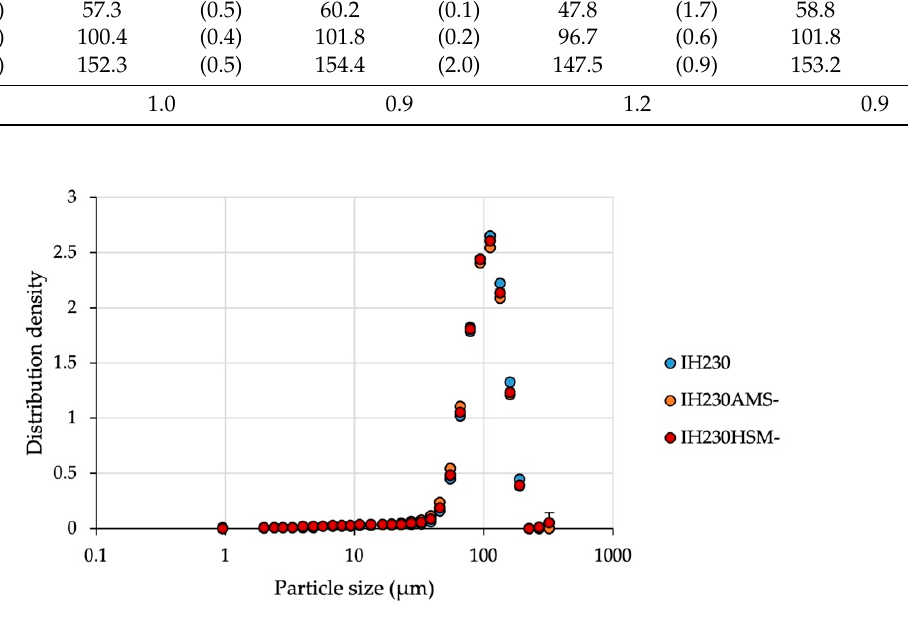
Figure 1. Particle size distribution density of the raw material in comparison to processed powders without the additive. n = 3, error bars show SD.